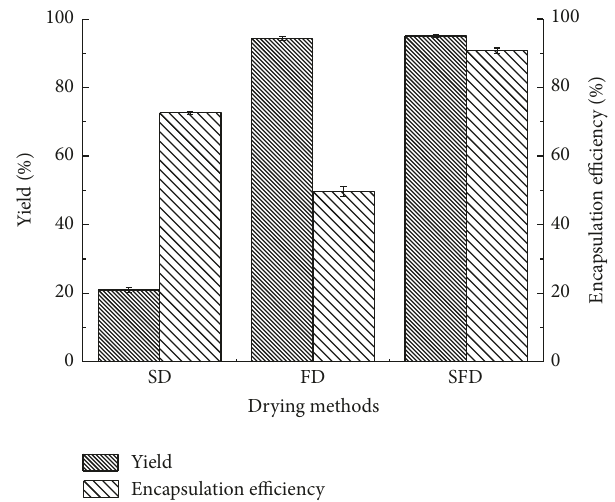
Figure 2: The productivity and encapsulation efficiency of different drying methods of fish oil